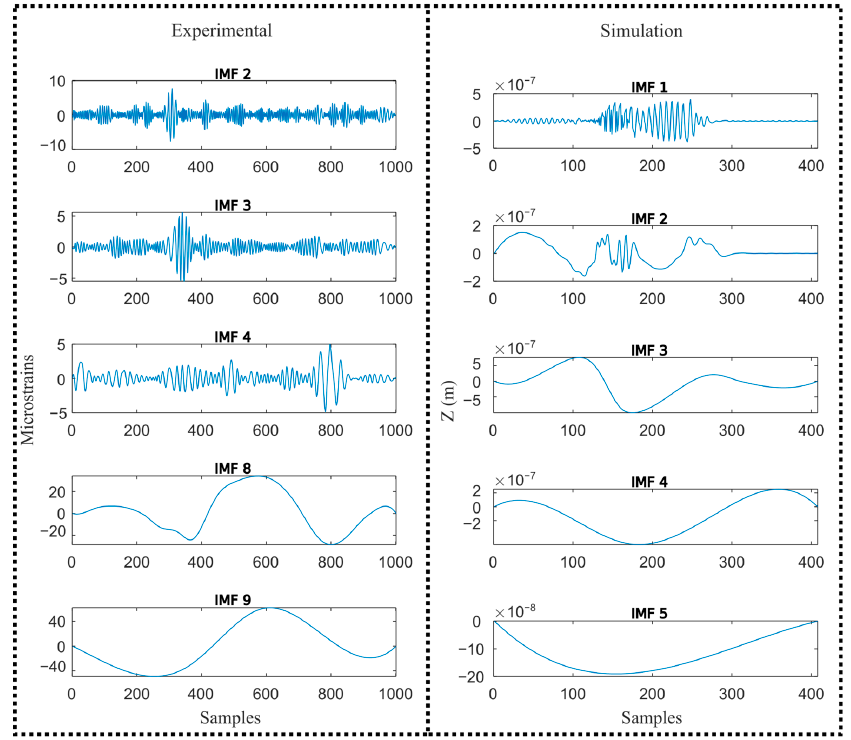
Figure 14. EMD decomposition of Figure 13 signals. The length of the vectors is limited to fewer samples so that only the high-amplitude vibrations are processed.